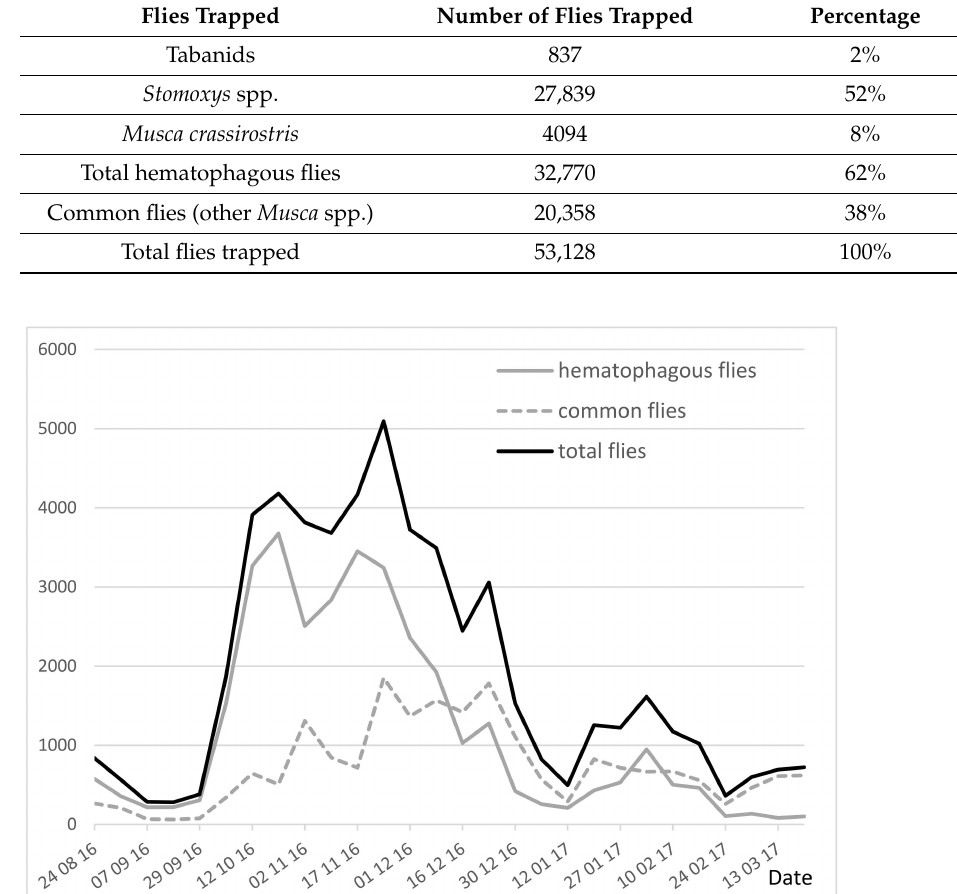
Figure 2. Number of hematophagous and non hematophagous Diptera flies trapped using 2 Vavoua and 1 Nzi traps in one day (IR12), once a week, in the study area (24 August 2016–17 March 2017). Legend: Black continuous line: total flies; grey continuous line: hematophagous flies; grey broken line: common